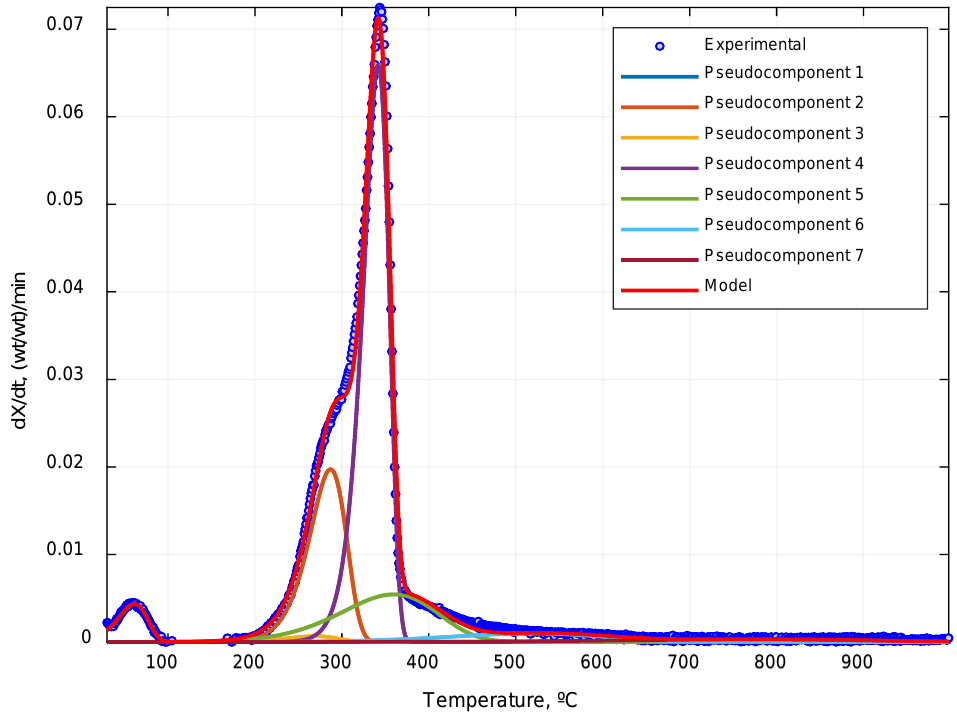
Figure 5. Model fitted to the experimental poplar DTG curve.